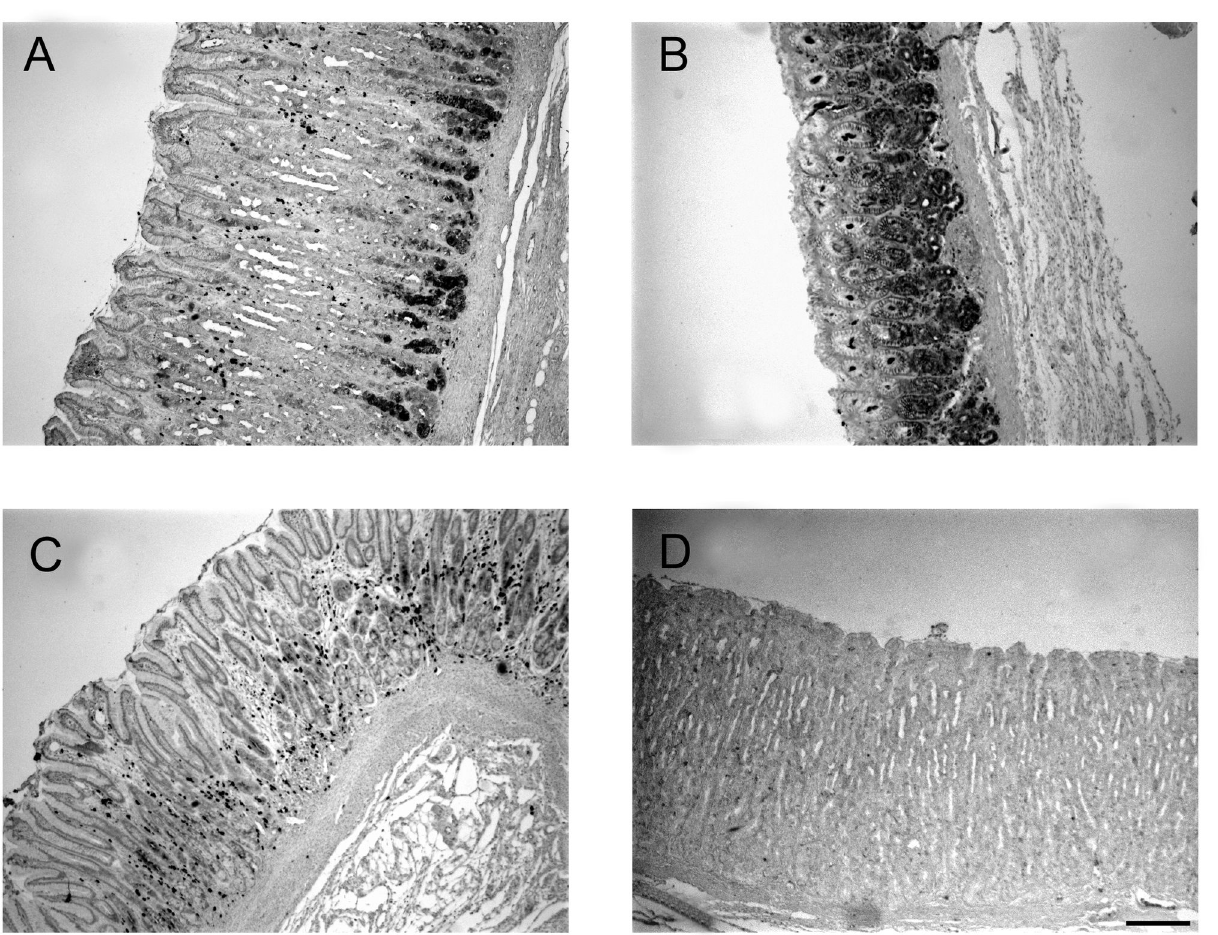
Figure 4. Localization of polymeric immunoglobulin receptor (pIgR) protein in three sites of the gastric mucosa of a representative pig aged 42 days. PIgR protein immunostaining in a 42 day-old representative piglet, in the transition from cardiac to oxyntic mucosa (A), in the proper glandular region (oxyntic mucosa) (B) and in the pyloric region (C). Negative control is with the omission of primary antibody (D). Bar indicates 200 µm (50× magnification).